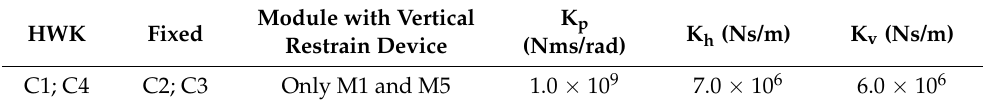
Table 3. Preliminarily optimal design parameters of the MIFS system.